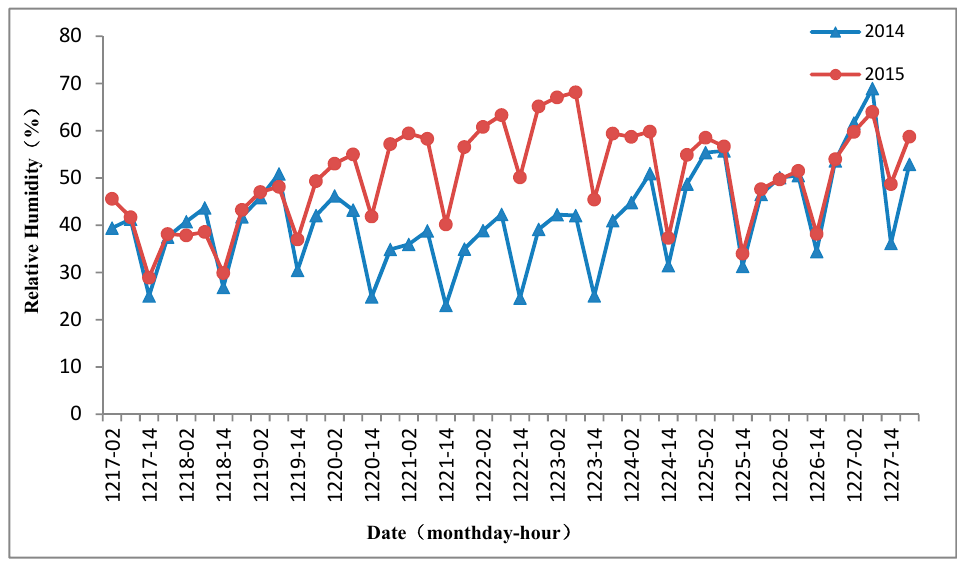
Figure 9. Relative humidity of Beijing-Tianjin-Hebei and its surrounding regions from 17 December to 27 December.